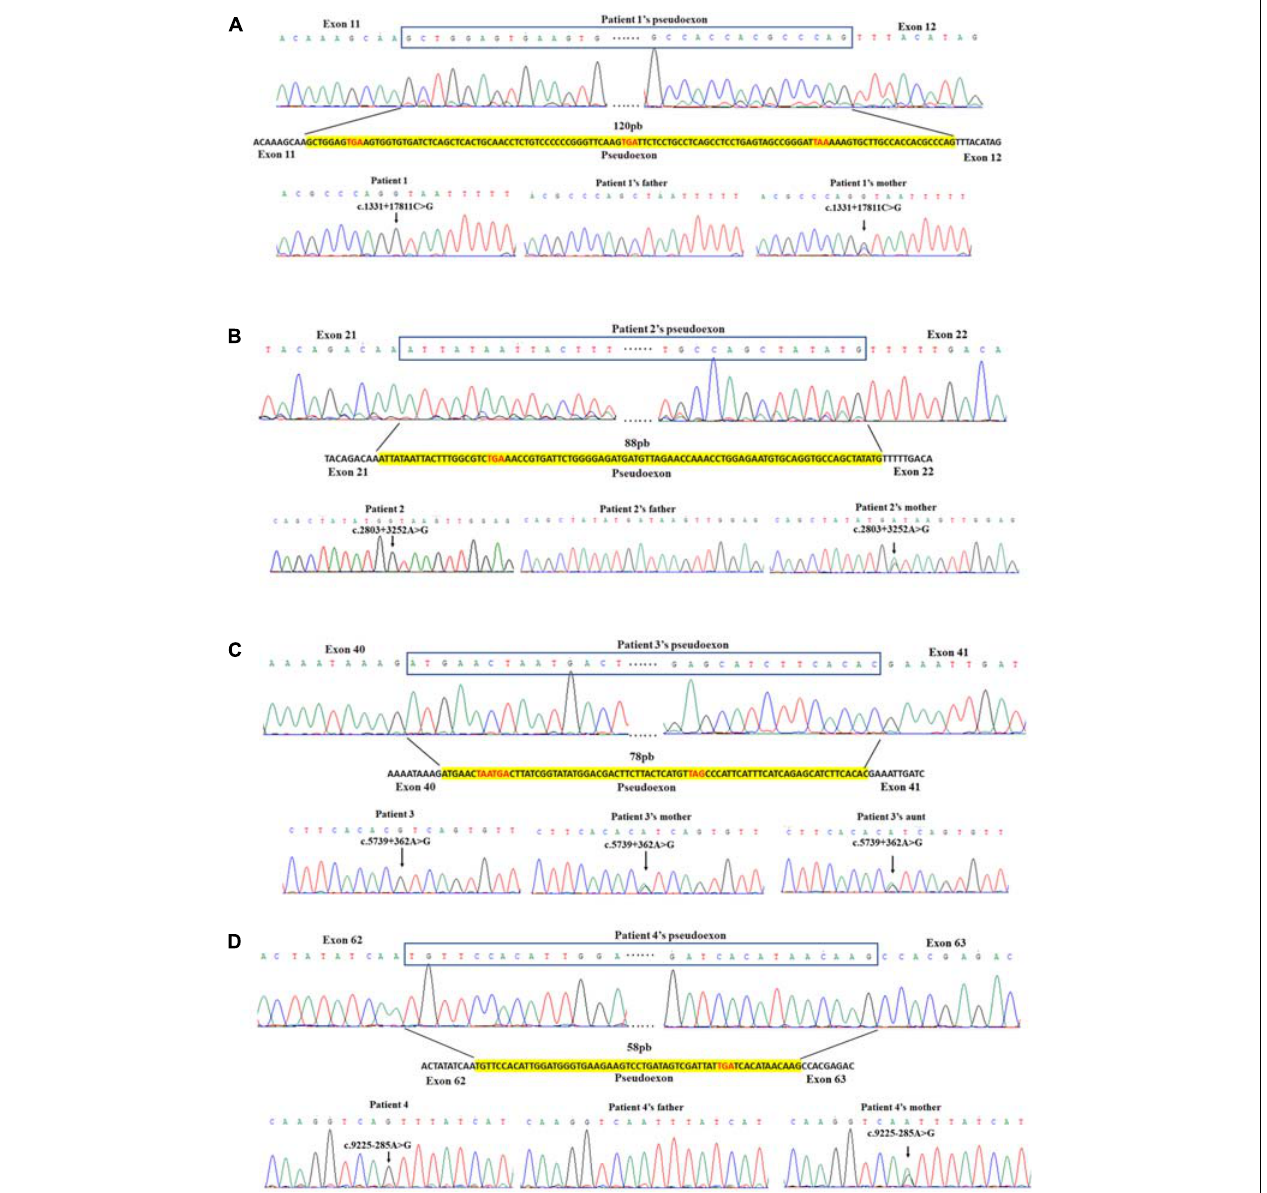
FIGURE 2 | Identification of pseudoexon and disease-causing mutation in patients 1–4 (corresponding to A–D ). Junctions of exon and pseudoexon were shown. Pseudoexons were squared in cDNA sequence, separated from exon junctions. Insertion sequence were heighted in yellow. Pseudoexon sizes (bp) were indicated above the insertion sequence, and premature stop codons were represented in red letters. The disease-causing deep intronic variant of each patient was displayed under the nucleotide sequence, together with sequencing results of their family pedigree. Arrows indicated the site of variant.